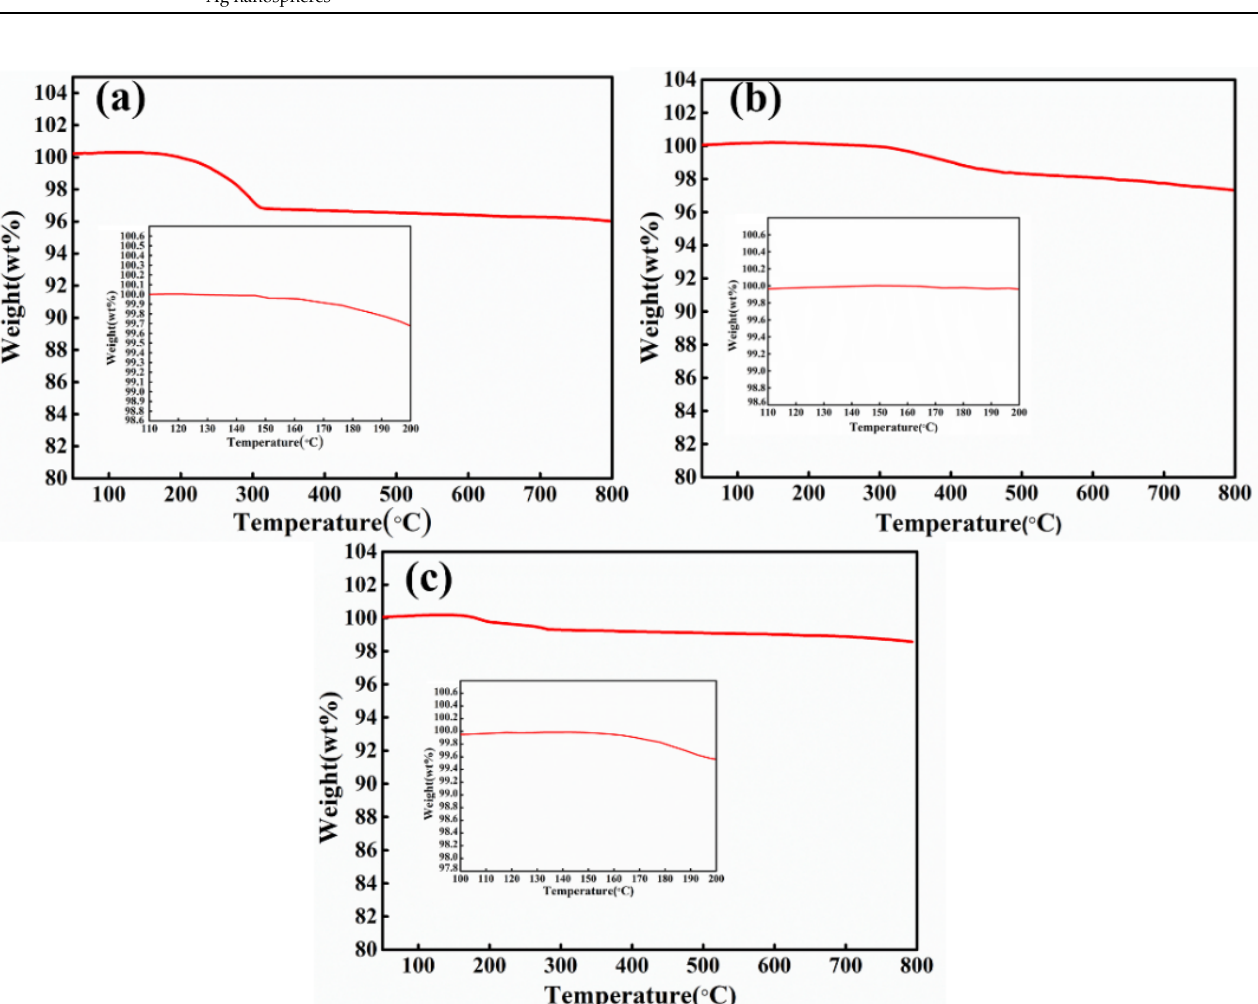
Figure 8. SEM images of silver paste paint film using WPU as the binder (sample F 20.0 P 2.5 W 7.5 ) at